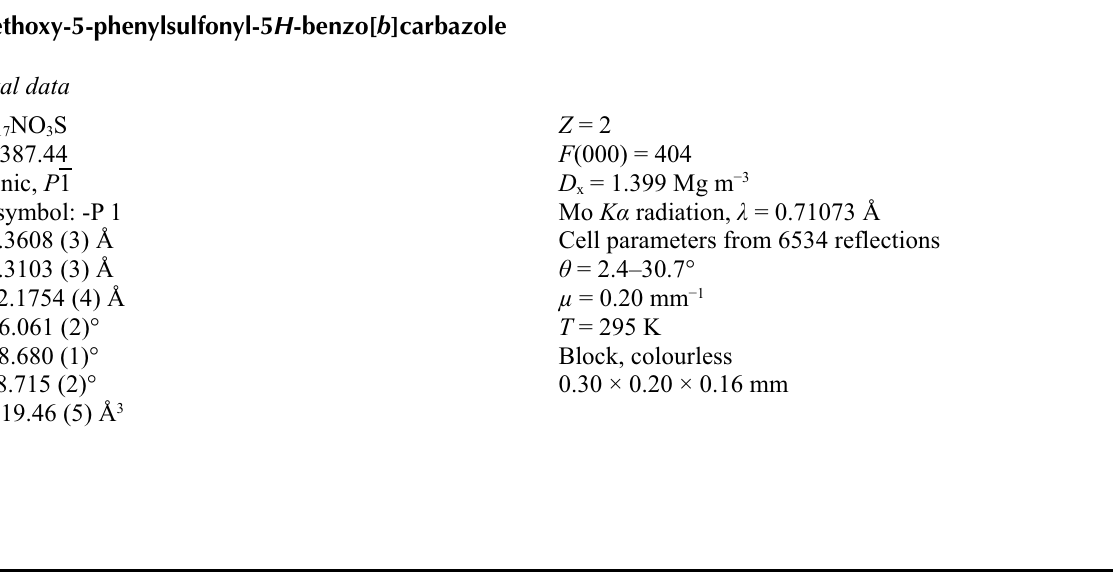
The molecular structure of (I), with atom labeling scheme. Displacement ellipsoids are drawn at 50% probability level. H atoms are presented as a small spheres of arbitrary radius. Intramolecular H-bonds are shown as dashed